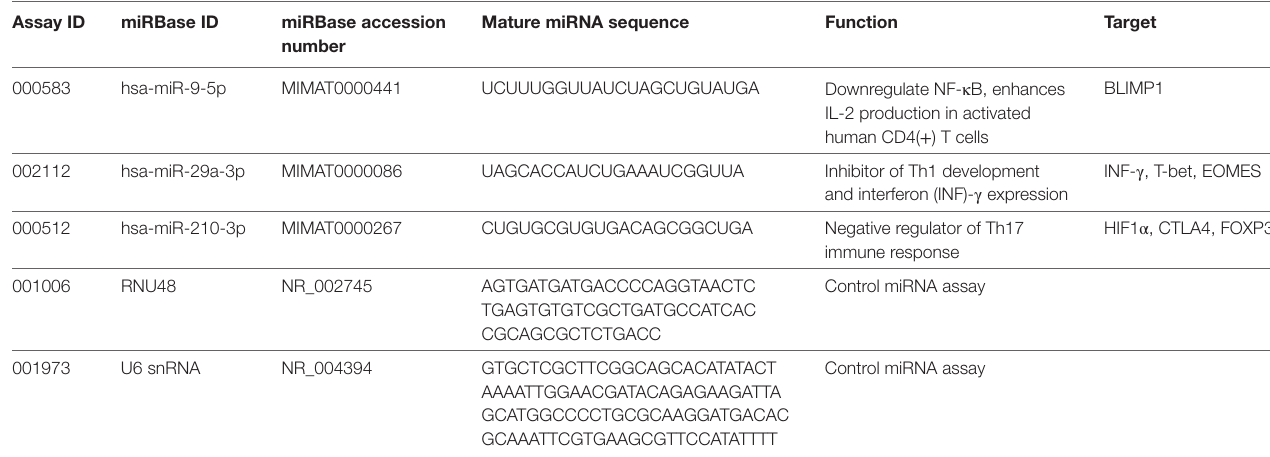
TaBle 1 | List of TaqMan assays of investigated